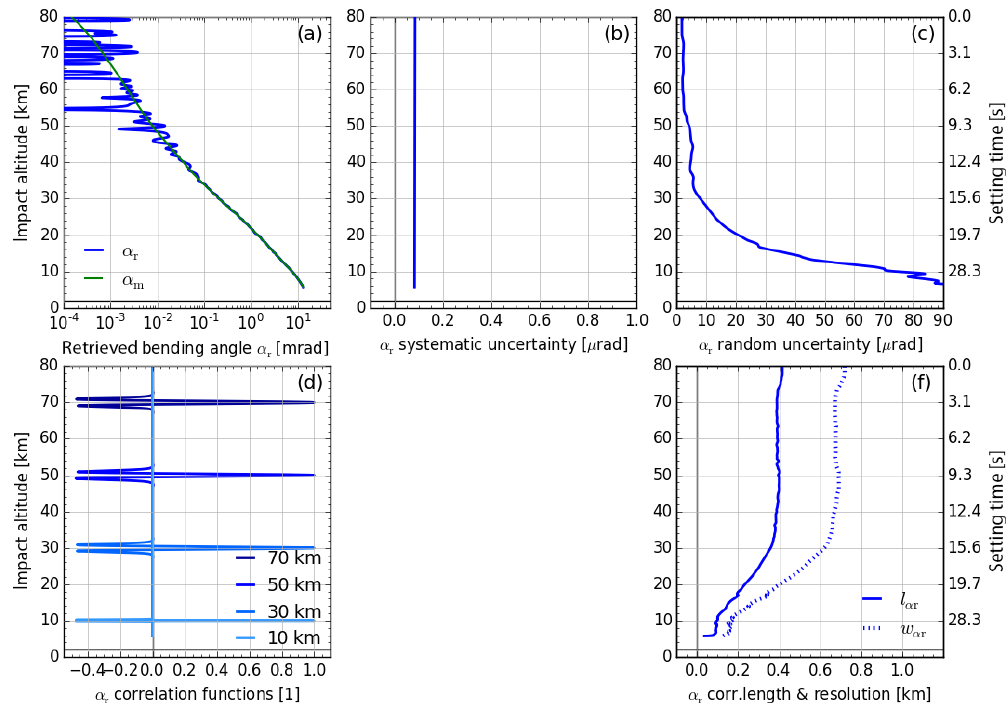
Figure 8. Results for atmospheric bending angle profile α r (with model profile α m for comparison) in panel (a) , systematic uncertainty profile u s α r in panel (b) , random uncertainty profile u r α r in panel (c) , representative correlation functions R α r ,i (at 10, 30, 50, and 70km) in panel (d) , and correlation length l α r (solid) and resolution profile w α r (dotted, estimated for main peak) in panel (f)